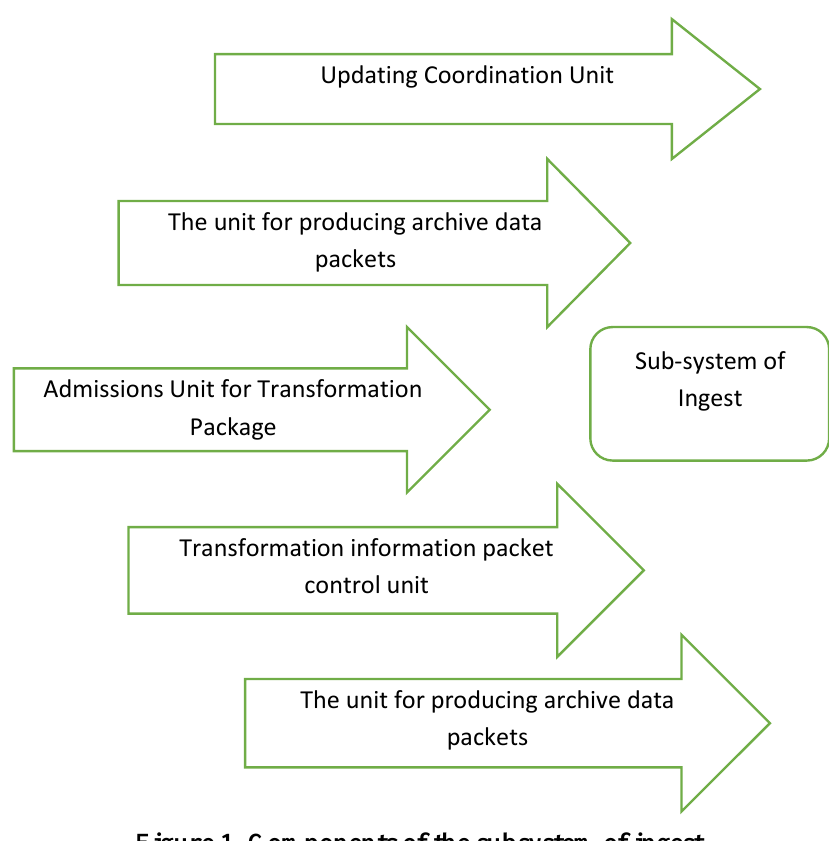
Figure 1. Components of the subsystem of